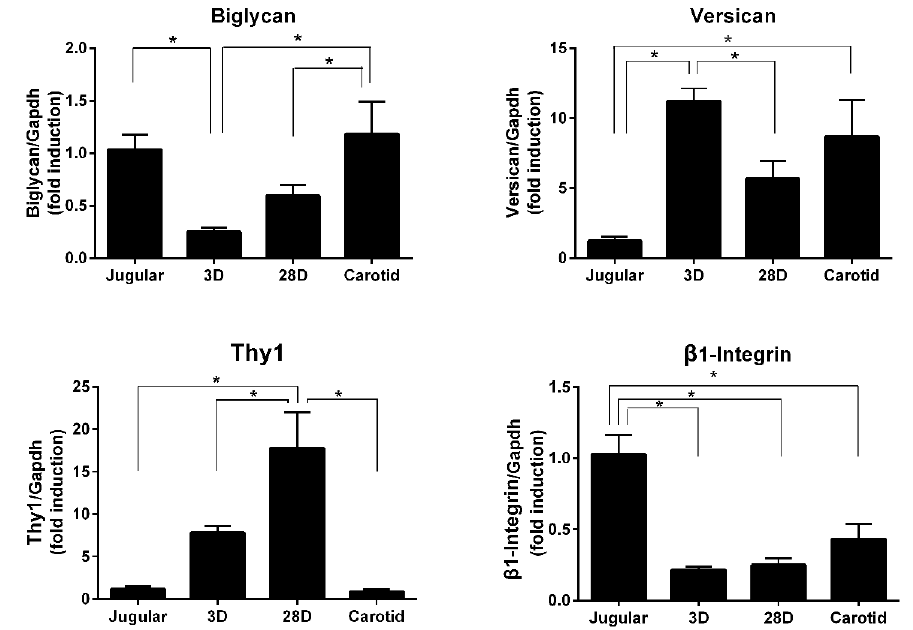
Figure 7. Extracellular matrix-related gene validation. qPCR analysis of versican (Vcan), Thy-1, biglycan, and β1-integrin to validate microarray data. Each bar represents the fold change expression compared with the level of expression in the jugular vein. Jugular ( n = 4), 3D ( n = 14), 28D ( n = 7), Carotid ( n = 5). * indicates p < 0.05.